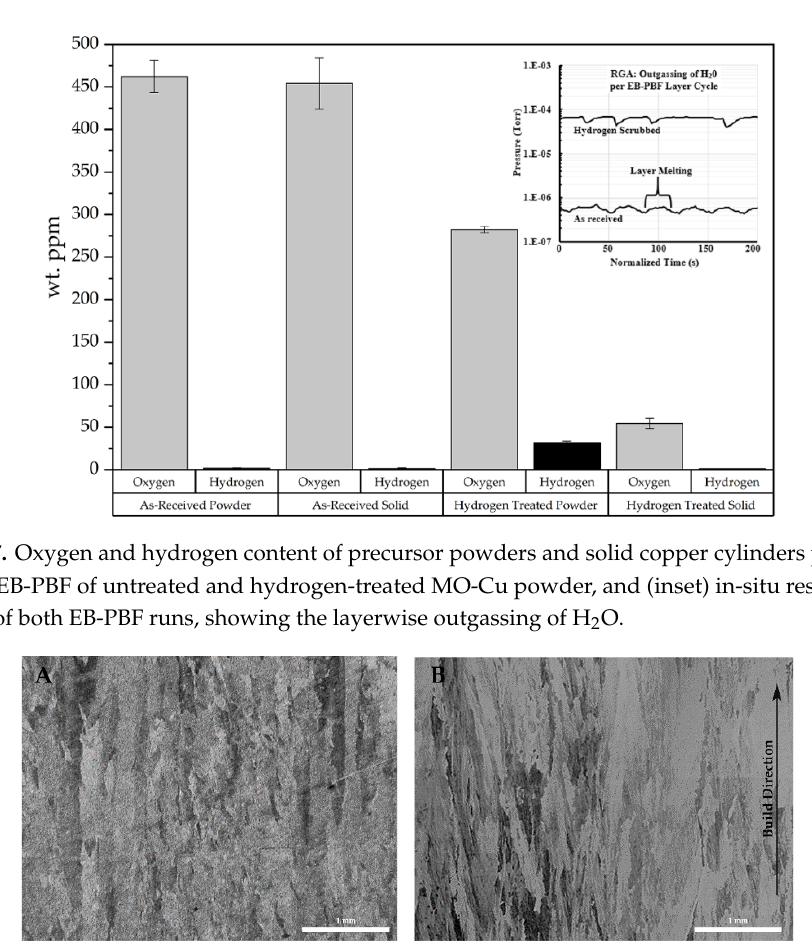
Figure 18. Optical micrographs showing polished and etched microstructures of copper samples fabricated with EB-PBF using hydrogen heat-treated MO-Cu powder ( A ) and untreated MO-Cu powder ( B ). The build direction for both samples are indicated by the arrow in B.